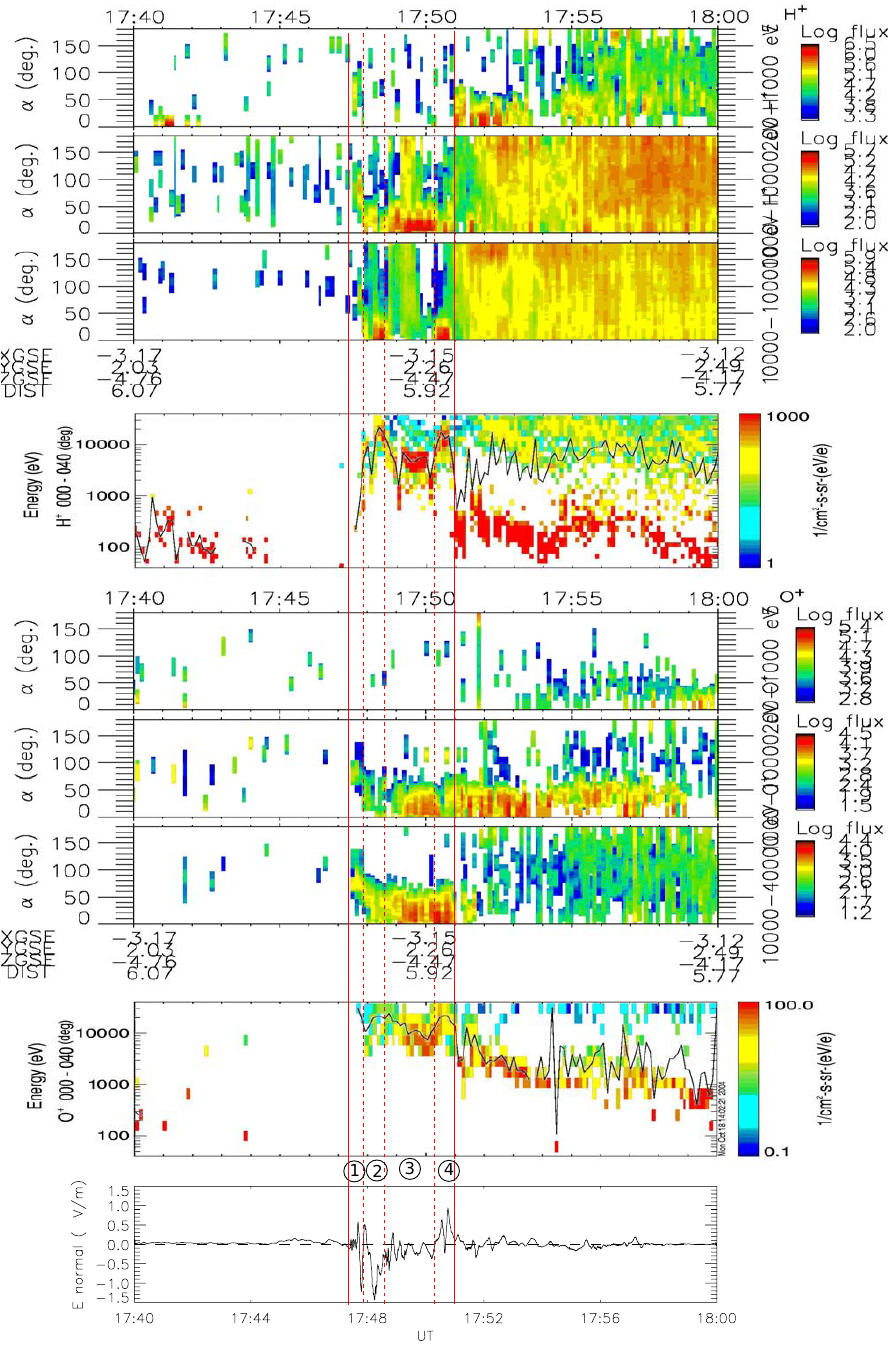
Fig. 1. CIS ion data measured on board Cluster spacecraft 1 on 8 May 2003. Panels 1 to 3 – H + ion flux spectrogram versus pitch angle and time for the energy intervals 200–1000eV, 1–10keV and 10–38keV, respectively. Pitch angle of 0 ◦ corresponds to upgoing and 180 ◦ to downgoing ions on the Southern Hemisphere. Panel 4 – Ion flux spectrogram versus energy and time for the upgoing (0–40 ◦ pitch angle) H + ions. The superposed black line indicates the corresponding characteristic energy. Panels 5 to 7 – O + ion flux spectrogram versus pitch angle and time for the energy intervals 200–1000eV, 1–10keV and 10–38keV, respectively. Panel 8 – Ion flux spectrogram versus energy and time for the upgoing (0–40 ◦ pitch angle) O + ions. The superposed black line indicates the corresponding characteristic energy. Panel 9 – Normal component of the electric field mapped to the